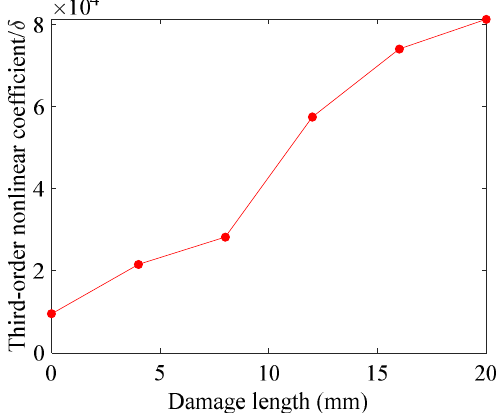
Figure 11. The changing curves of the second-order nonlinear coefficient.